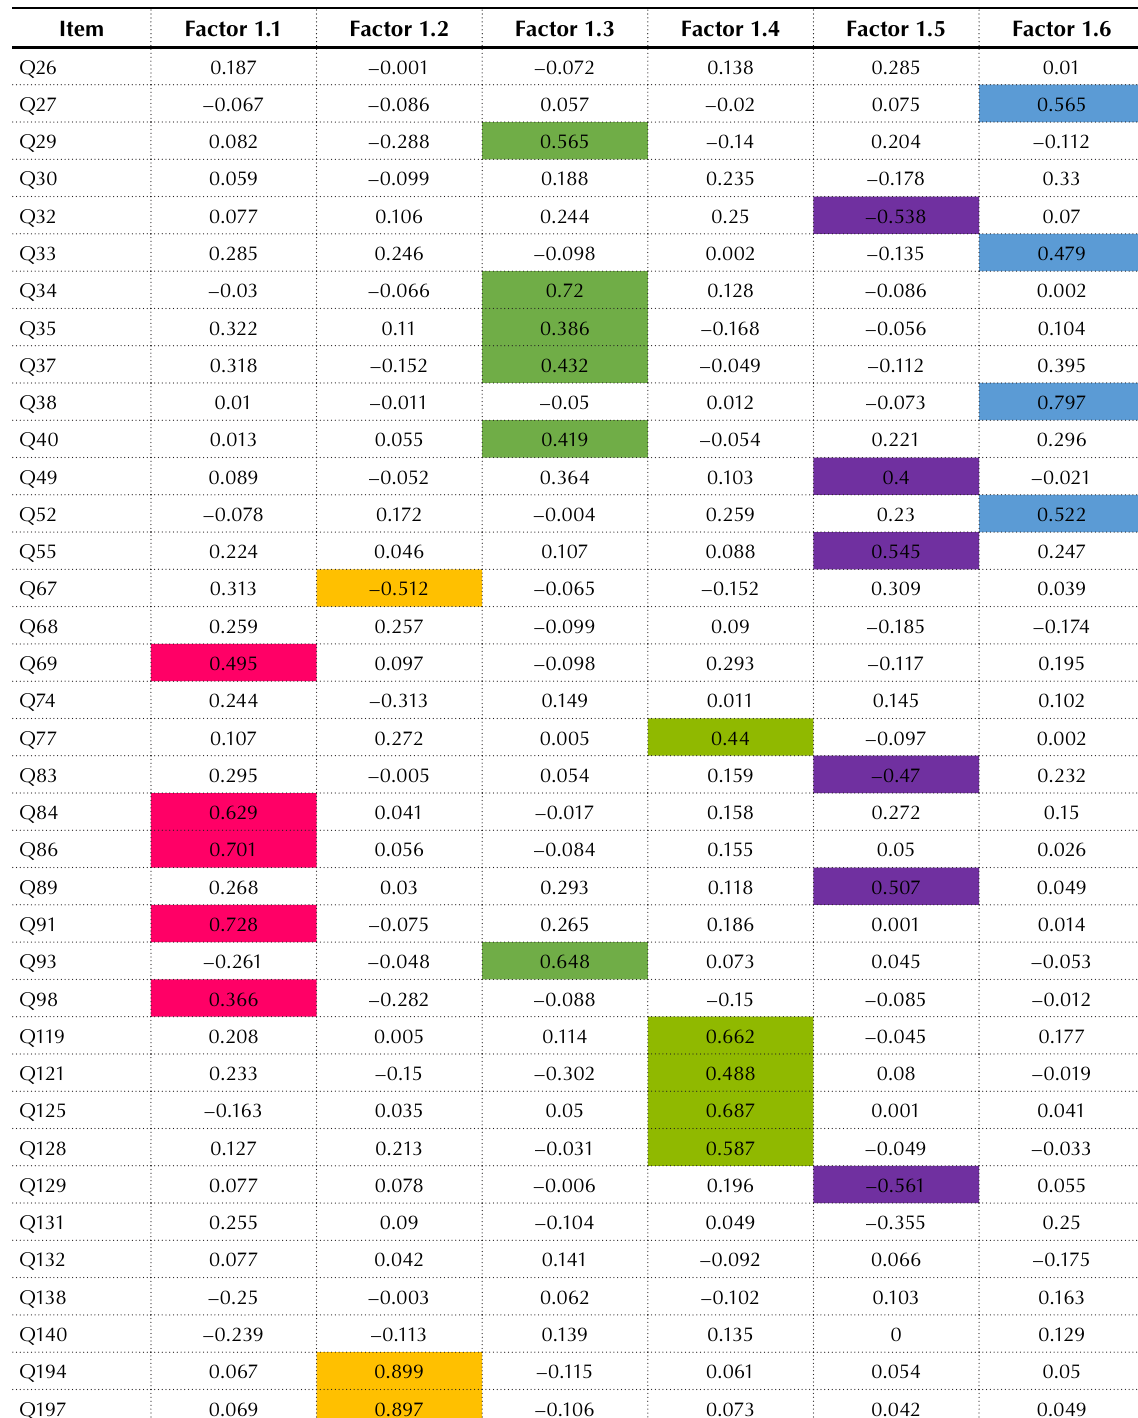
Table 5. Equamax factor rotation on the barriers to effective